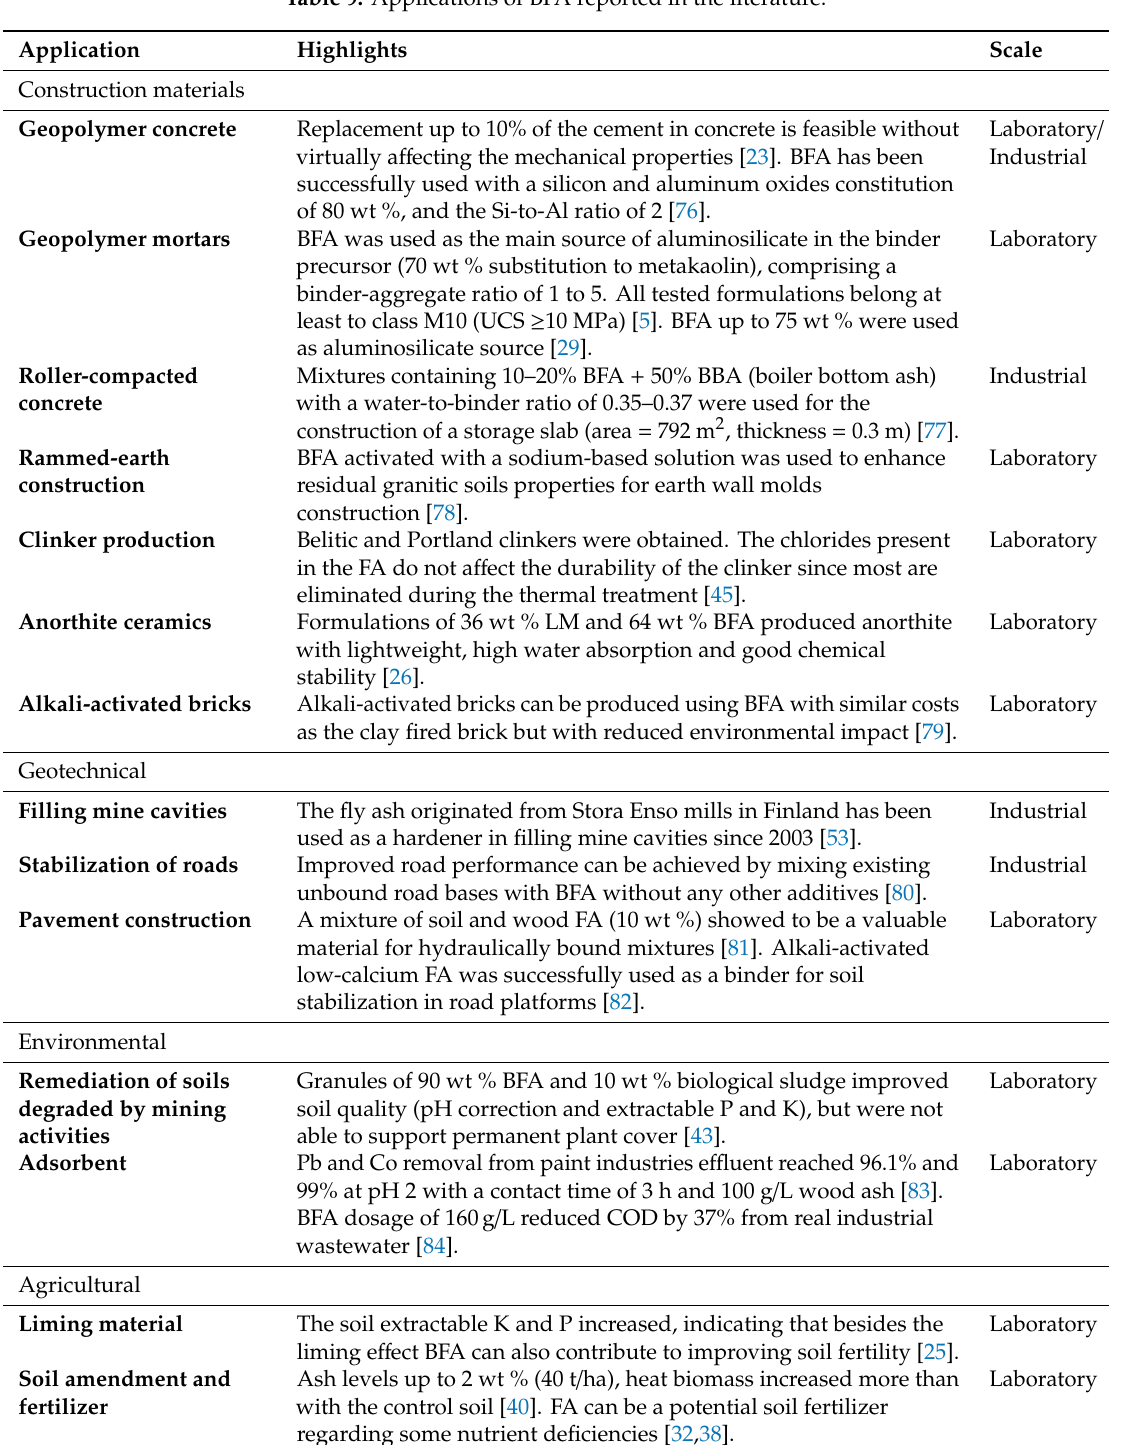
Table 9. Applications of BFA reported in the